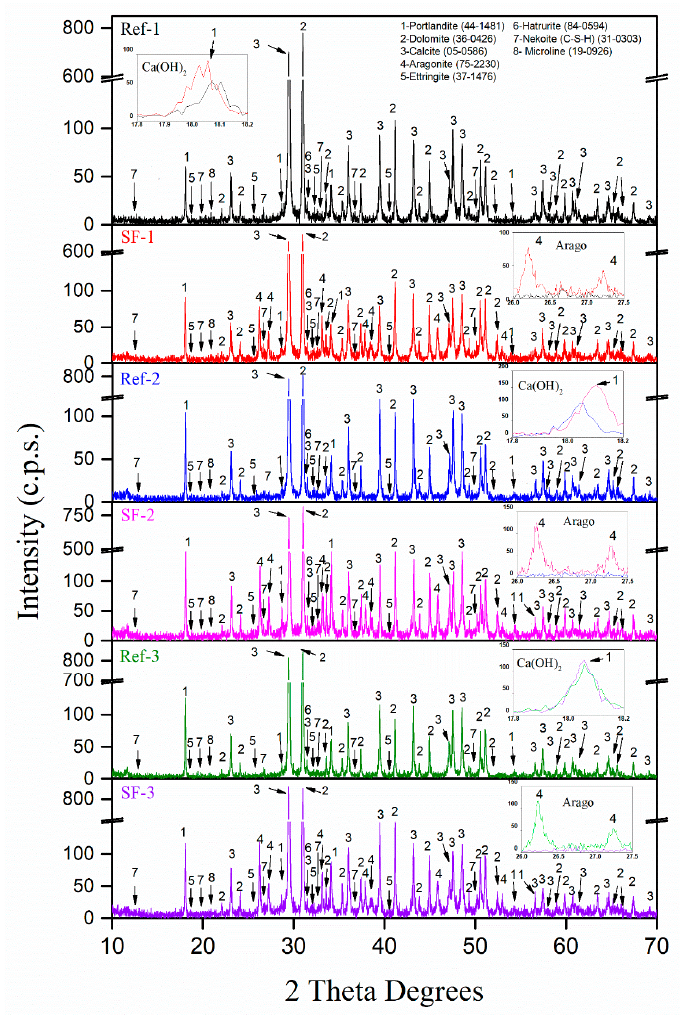
Figure 9. XRD diffraction of all reference and seashell filler (SF) mixtures.